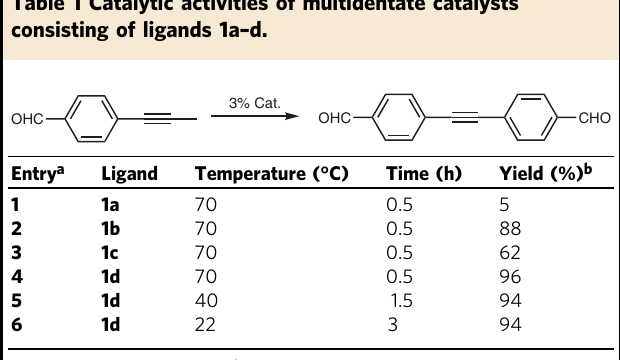
best performing solvent and also highly immiscible with water (0.13 g H 2 O/kg CCl 4 , 130 ppm). After mixing the precursor and the ligand 1d (ratio = 1:1 for activation) in CCl 4 for 10 min under argon, the catalyst mixture was taken out of the glove box and transferred to a rotavapor. The solvent was removed by rotary evaporation and a solution of the substrate (0.1 mmol) in CCl 4